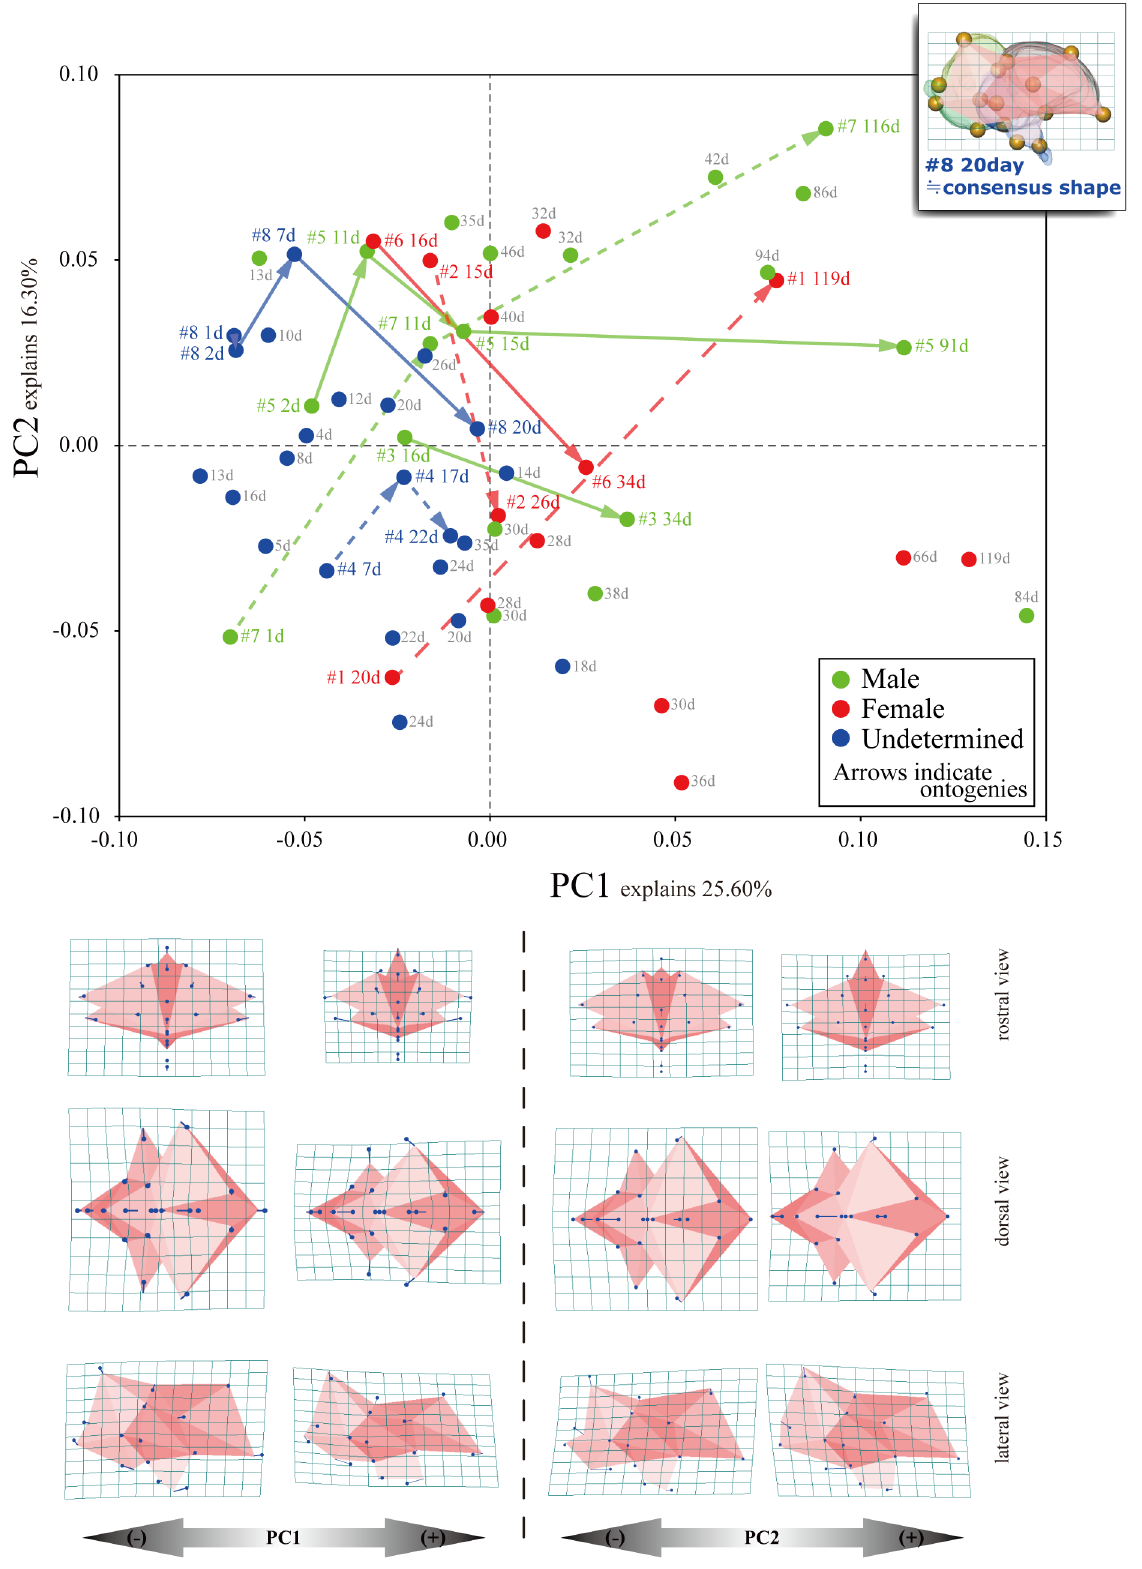
Fig 3. Ontogenetic shape variations (#1 to #8) (not to scale). doi:10.1371/journal.pone.0129939.g003 PLOS ONE | DOI:10.1371/journal.pone.0129939 June 8,